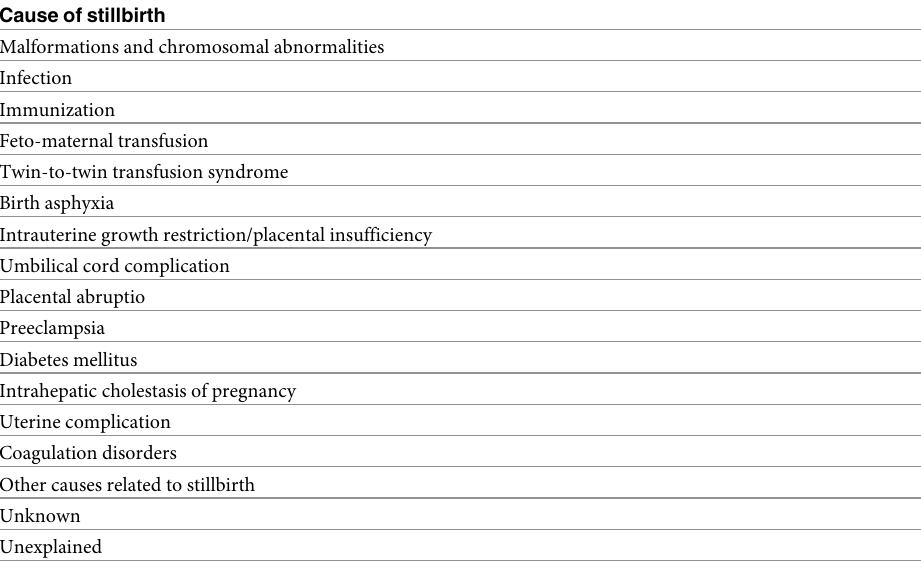
Table 1. Classification of stillbirth according to the Stockholm Stillbirth